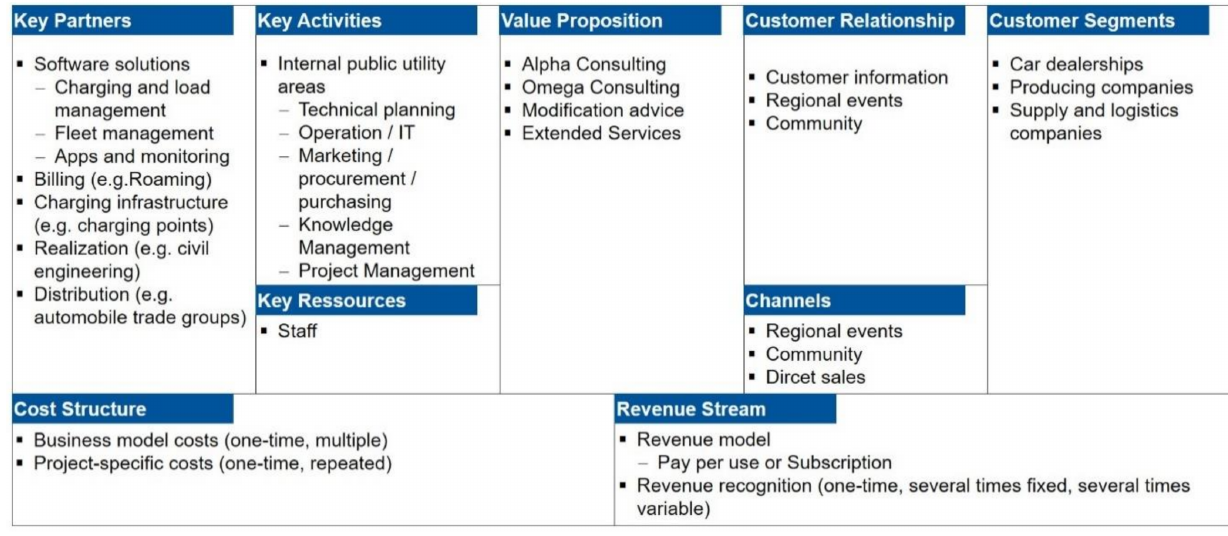
Figure 5. Results of Business Model Canvas.